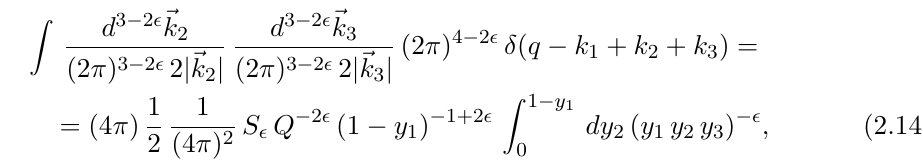
Figure 2 . The phase space available for the three final state massless particles g , q and ¯ q , with mo- menta k , k and k , respectively. The dashed (red) bands represent the quasi 2 -jet configurations, 1 3 2 where y and/or y are zero. The sub-regions R 1 2 = 1 − y (or y = 0 ), due to momentum conservation. Since the fragmenting y 2 1 3